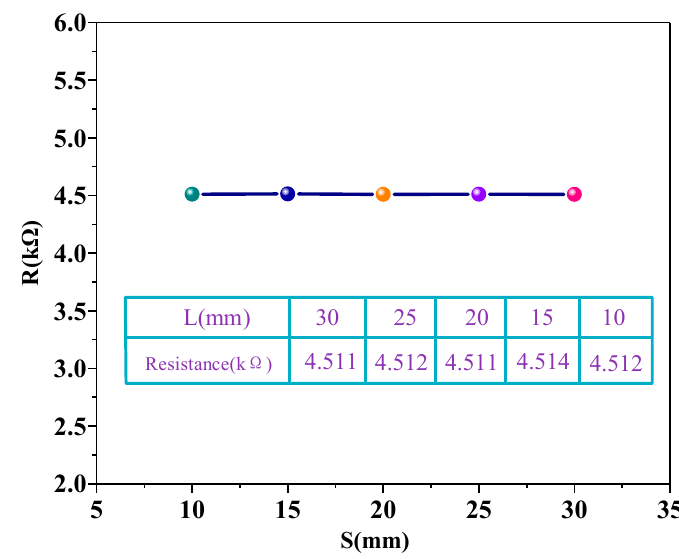
Figure 7. The resistance change in the r-GO sensor when bending. The table in this figure shows the specific change in resistance.